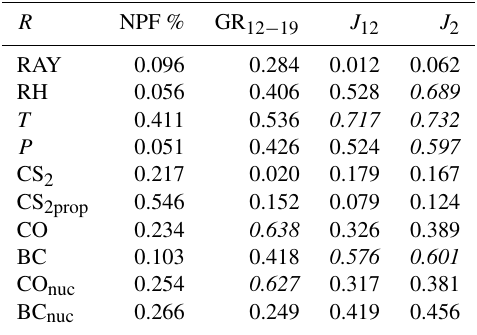
Figure 8. (a) Temperature ( ◦ C) and incidental radiation (Wm − 2 ) variations during 2015 at Maïdo station given by daily UTC (fine) and monthly (bold) averages; (b) seasonal variation in sunrise and time of NPF onset in local time (LT). The dry and wet seasons are also delimited in orange and blue, respectively.